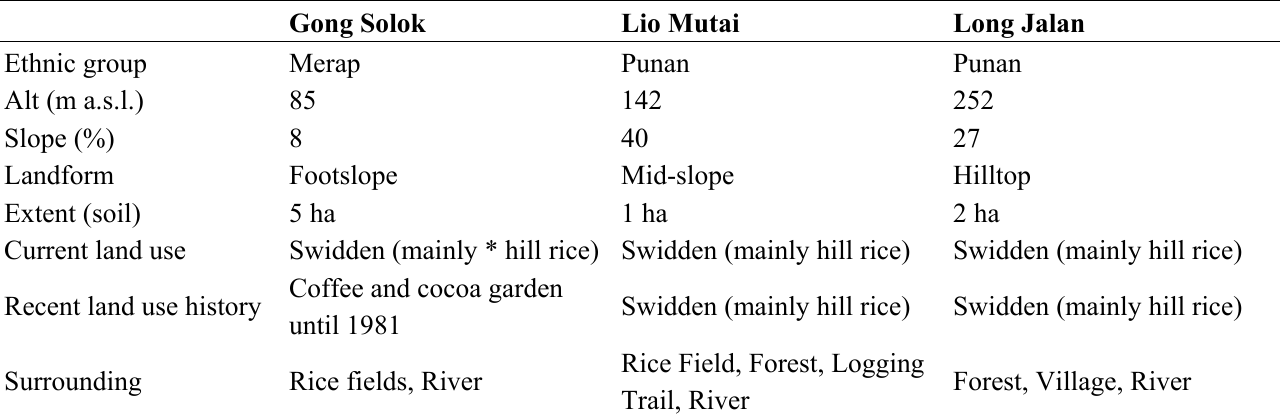
Table 2. Site description of black soil areas in each village. Gong